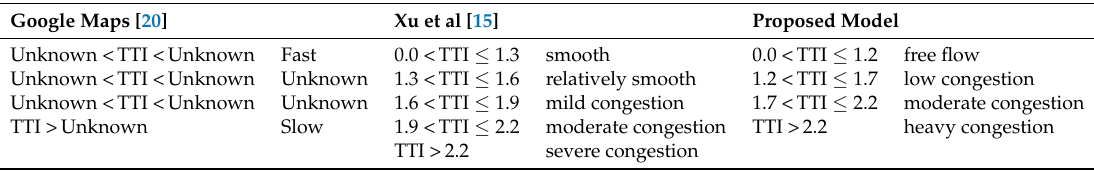
Table 1. Travel time index (TTI) class intervals and